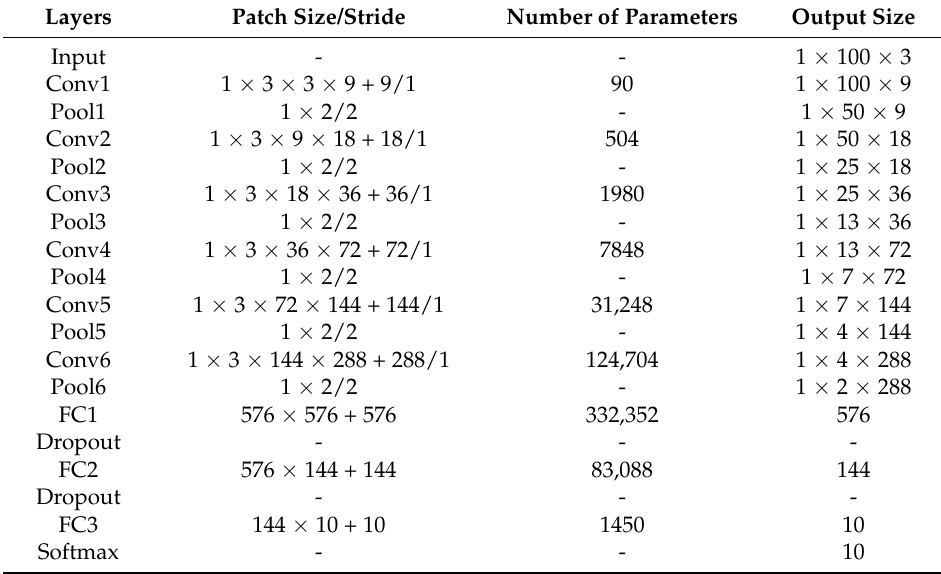
Table 1. The detailed structure of the CNN used in the proposed algorithm. Layers